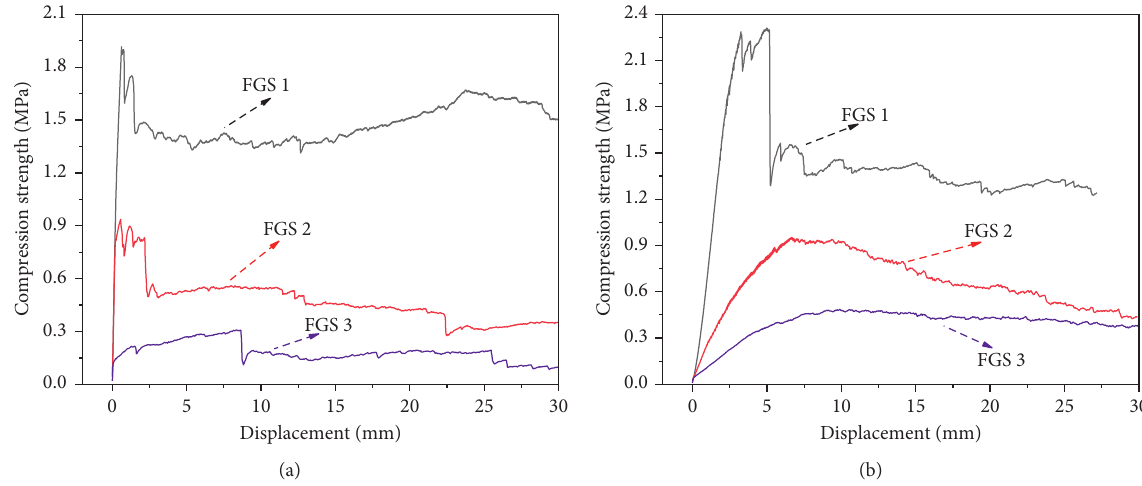
Figure 14: Compressive strength-displacement curve for LASC foam cement filling materials. (a) 1d, (b)